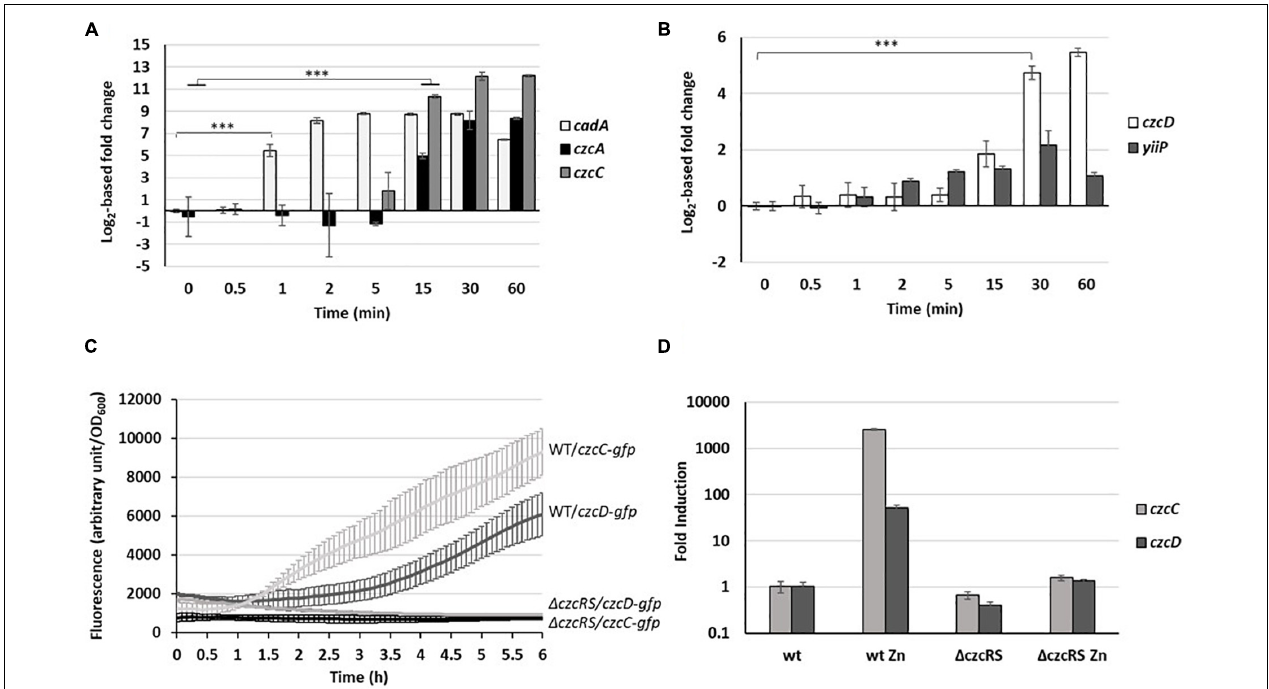
FIGURE 2 | Fold change expression of export systems. (A) cadA (P-type ATPase), czcA and czcC (RND) as well as (B) yiip and czcD (CDF) fold change in the copy number of transcripts measured using the NanoString technology before and after addition of 2 mM ZnCl 2 and monitored over the time. Mean values of fold change compared to t0 (before addition of Zn) and standard deviations (error bars) of three independent experiments are represented. Statistical analyses were performed according to the Student’s t -test and p -values are given as follows: ≤ 0.001 ( ∗∗∗ ). (C) Fluorescence measurement of pczcC::gfp ( czcC ) and pczcD::gfp ( czcD ) in the WT strain and the (cid:49) czcRS mutant after addition of 2 mM ZnCl 2 . Values are normalized by optical density (OD 600 ). Standard deviations (error bars) of three measurements are indicated. (D) qRT-PCR analysis of czcC and czcD mRNAs taken 2 h after addition of 2 mM ZnCl 2 . The amount of mRNA is represented relative to time 0 (set to 1), before addition of ZnCl 2 . Results are normalized using the oprF gene and standard deviations (error bars) of three independent experiments are